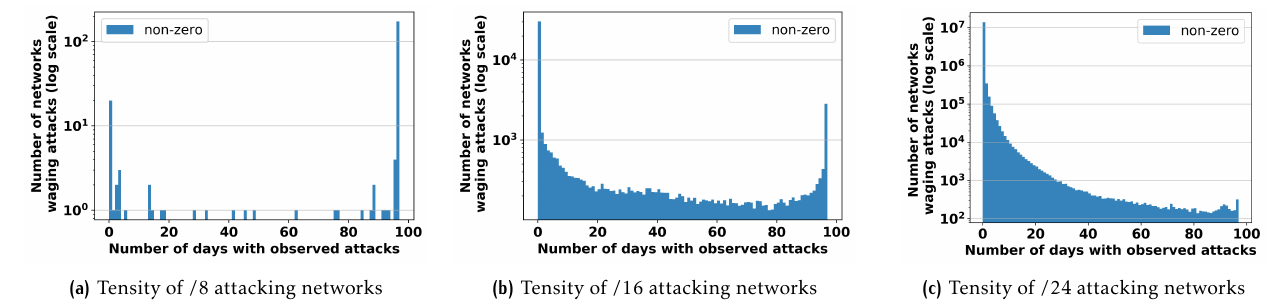
Figure 5. Plots of attack tensity: the number of networks ( y -axis, in log scale) that waged attacks during x of the T = 97 days. /24 networks wage 1 attack per day for the first 90